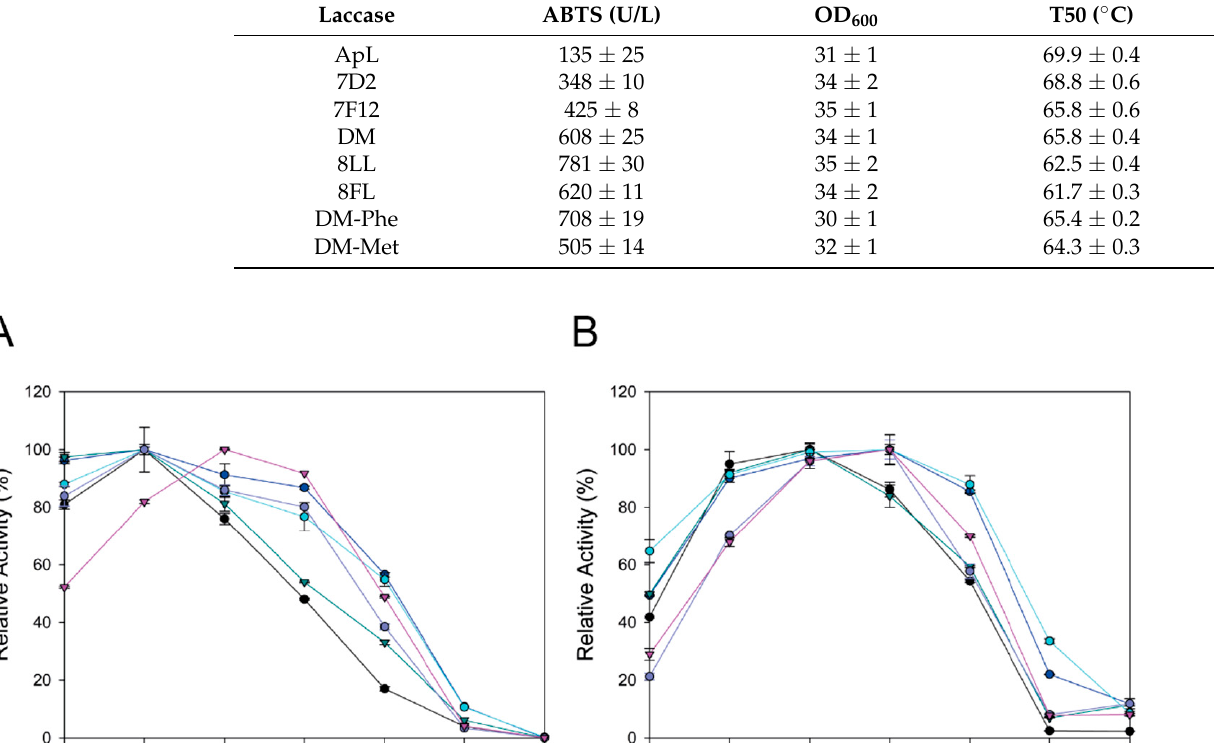
Table 2. Secreted laccase activities and OD 600 of flask liquid cultures of S. cerevisiae expressing the native ApL and the developed variants after 96 h of incubation at 28 ◦ C. Thermotolerance is presented as T50 (10 min) values. Laccase